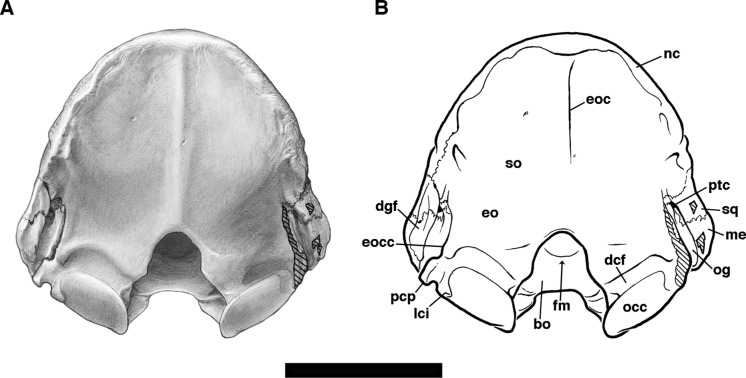
Skull of Holmesina floridanus in posterior view.(A) UF 191448; (B) Reconstruction. bo, basioccipital; dcf, dorsal condyloid fossa; dgf, digastric fossa; eo, exoccipital; eoc, external occipital crest; eocc, exoccipital crest; fm, foramen magnum; lci, lateral condyle indentation, i.e., indentation on lateral edge of occipital condyle; nc, nuchal crest; occ, occipital condyle; og, groove for occipital artery; me, mastoid exposure of petrosal; pcp, paracondylar process of exoccipital (=paroccipital process of Patterson, Segall & Turnbull (1989)); ptc, posttemporal canal; so, supraoccipital; sq, squamosal. Scale bar = 5 cm.